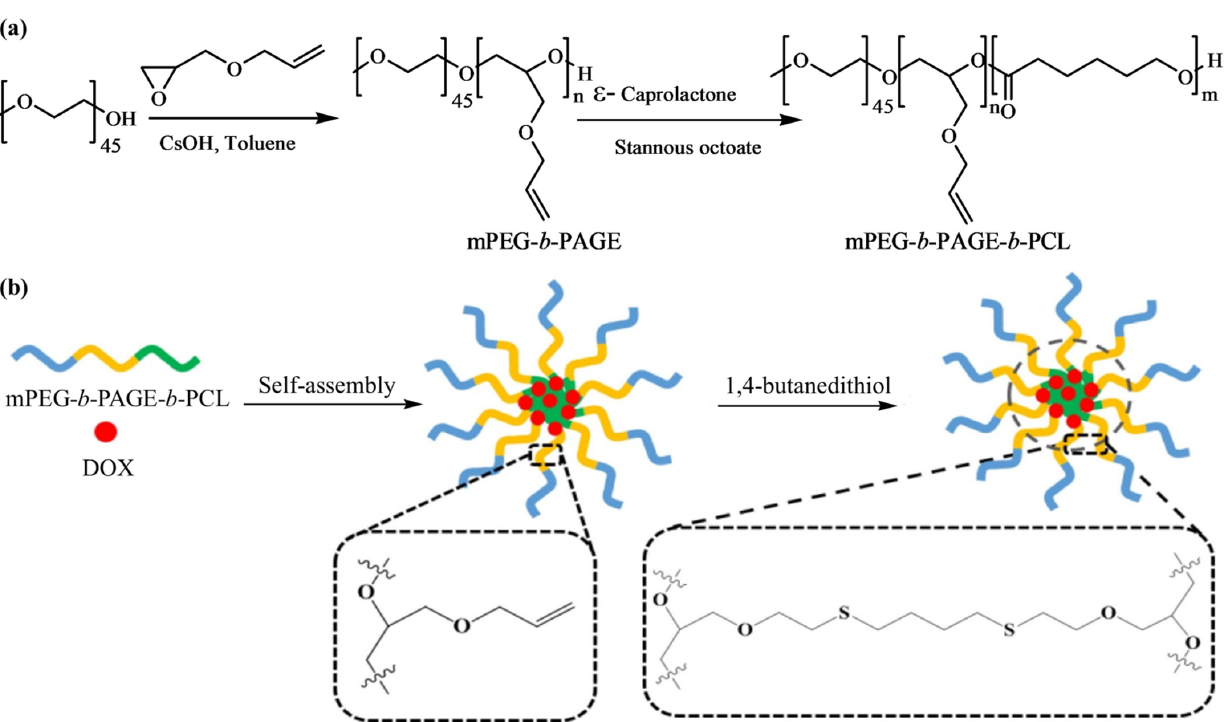
Figure 12. The synthetic procedure of mPEG- b -PAGE- b -PCL ( a ) and the preparation of the DOX-loaded CLM by “thiol-ene” reaction ( b ) as described by Lu et al. Adapted with permission from [51]; published by Elsevier, 2020.